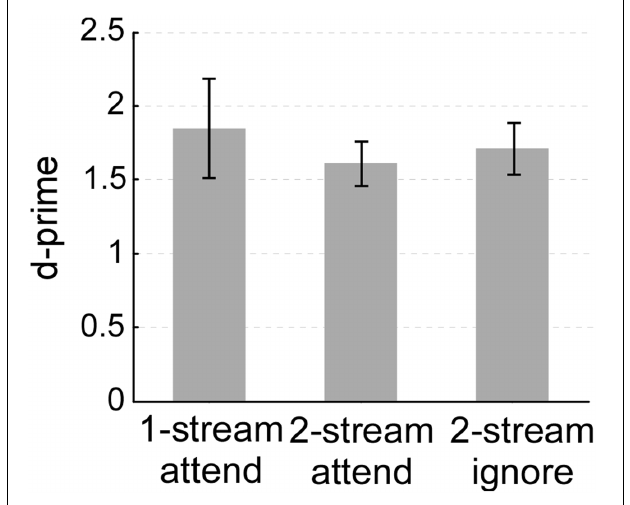
FIGURE 2 | Behavioral performance (d-prime) in the one-stream attend, two-stream attend or two-stream ignore experiments. Error bars denote one standard